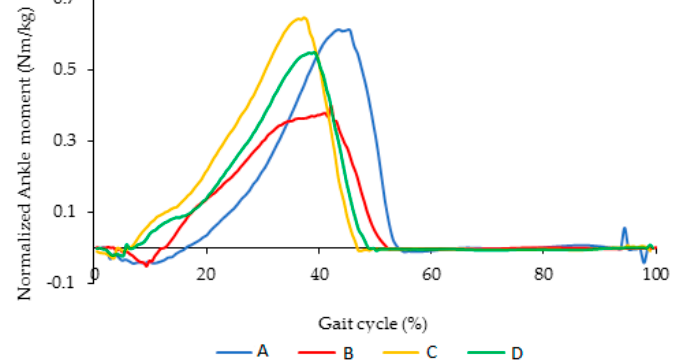
Figure 9. Normalized ankle moment versus percentage of gait cycle during normal walking (A), AFO with Stainless Steel spring (B), and using AFO with superelastic NiTi spring (C and D). (Case ІІ ). Ankle torque-angle loop profile can be considered as normalized ankle moment in respect to ankle rotation (plantar/dorsiflexion). Ankle torque-angle loop is the resistance of the ankle joint in